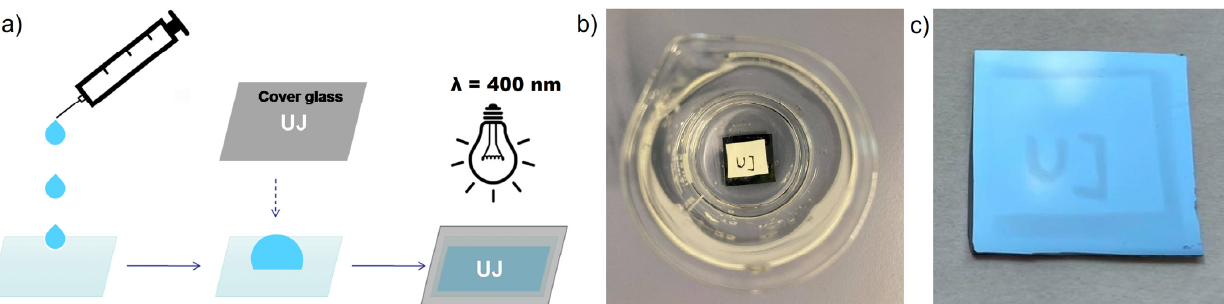
Figure 11. Scheme of the synthetic approach used for the creation of “UJ” pattern ( a ) with photos presenting plate with white homemade photomask ( b ) and final PTPM brushes grafted from silicon wafers ( c ).